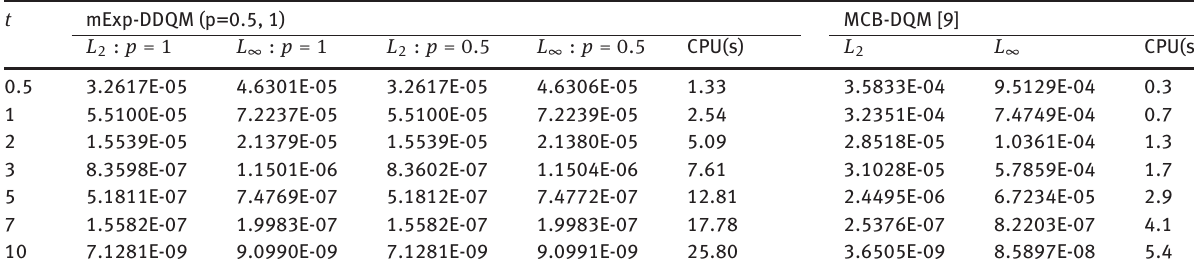
Table 10: Comparison of the mExp-DQM solutions of Example 5.5 with h = 0.05, (cid:2) = 0.001, α = β = 1, p = 0.5, 1